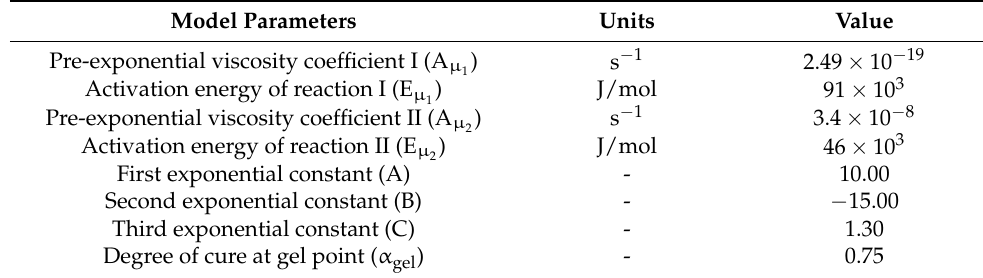
Table 3. OM12 resin system rheology model parameters. Model Parameters Units Value Pre-exponential viscosity coefficient I (A µ 1